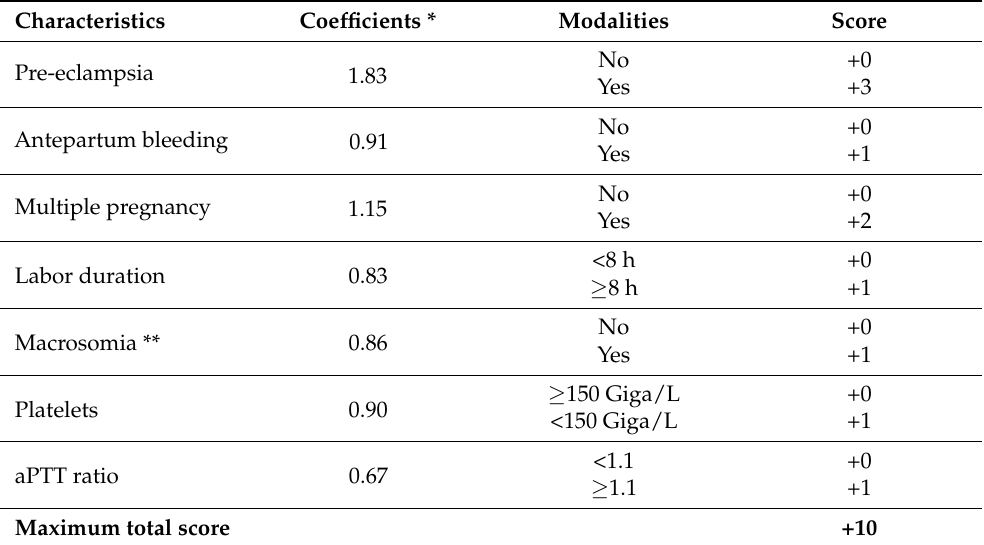
Table 3. Predictive score for